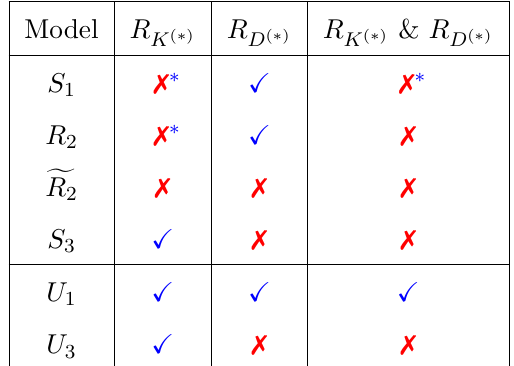
((cid:12)rst column), R (second K ( (cid:3) ) D ( (cid:3) )